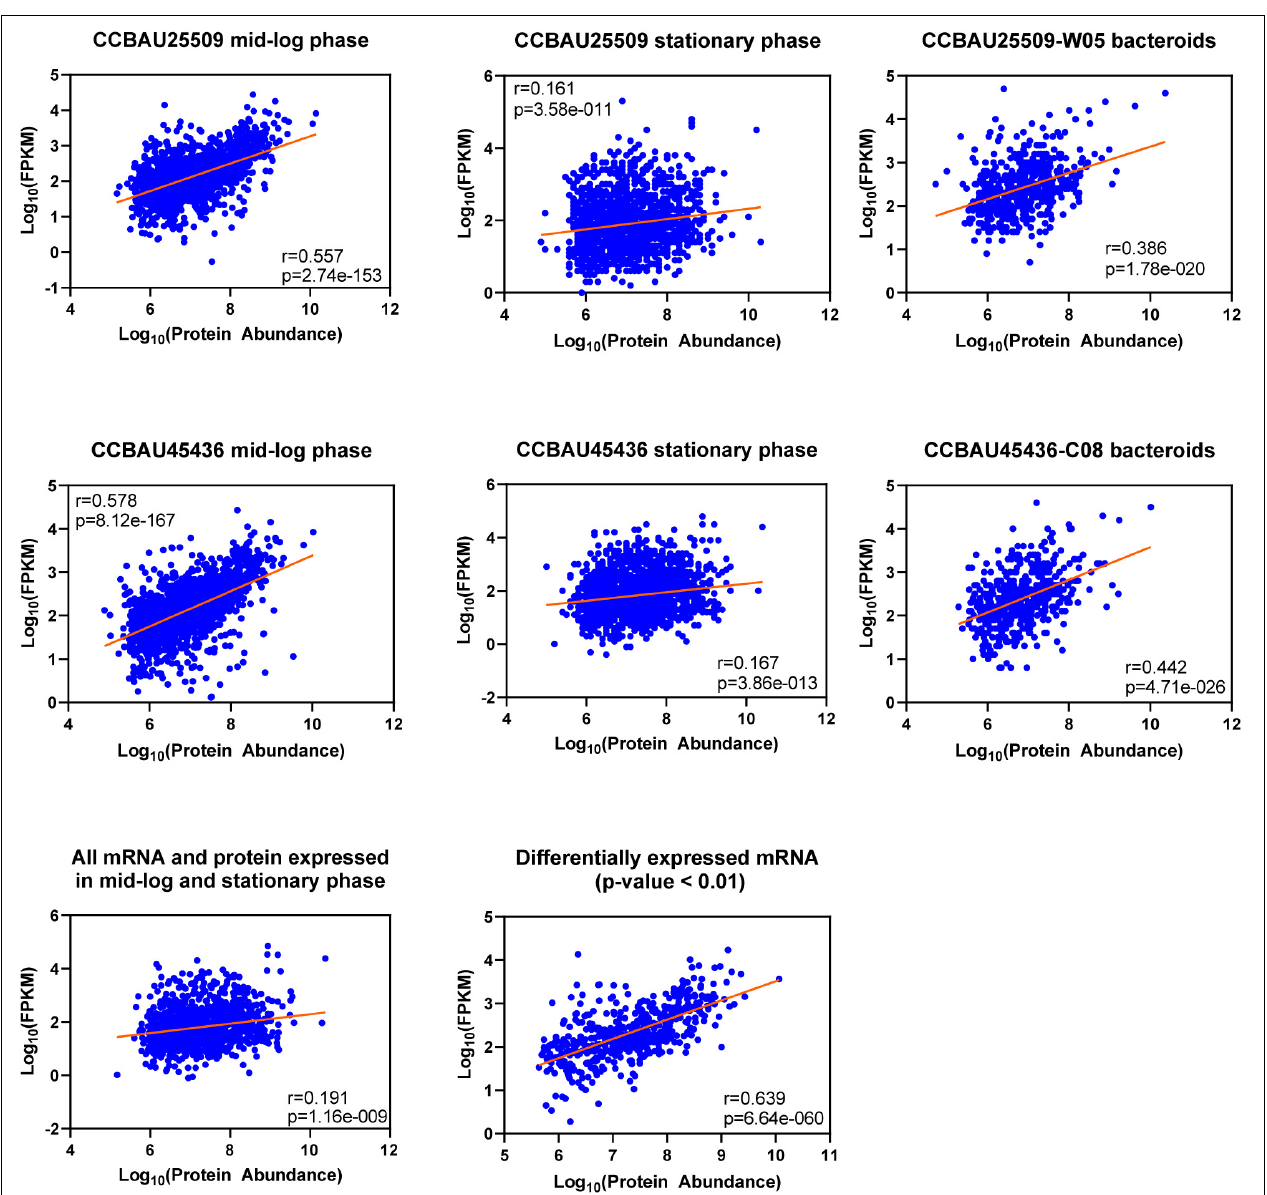
FIGURE 2 | Overall correlation between the levels of label-free quantified (LFQ) proteins and mRNAs at different growth stages of S. fredii CCBAU25509 and CCBAU45436. The figures were drawn based on Log 10 abundance values of proteome and transcriptome datasets. Averaged abundance of proteins of three biological replicates were used. W05: a G. soja accession; C08: a G. max accession. Pearson’s correlations were calculated using GraphPad Prism 8.2.1 at 95% confidence